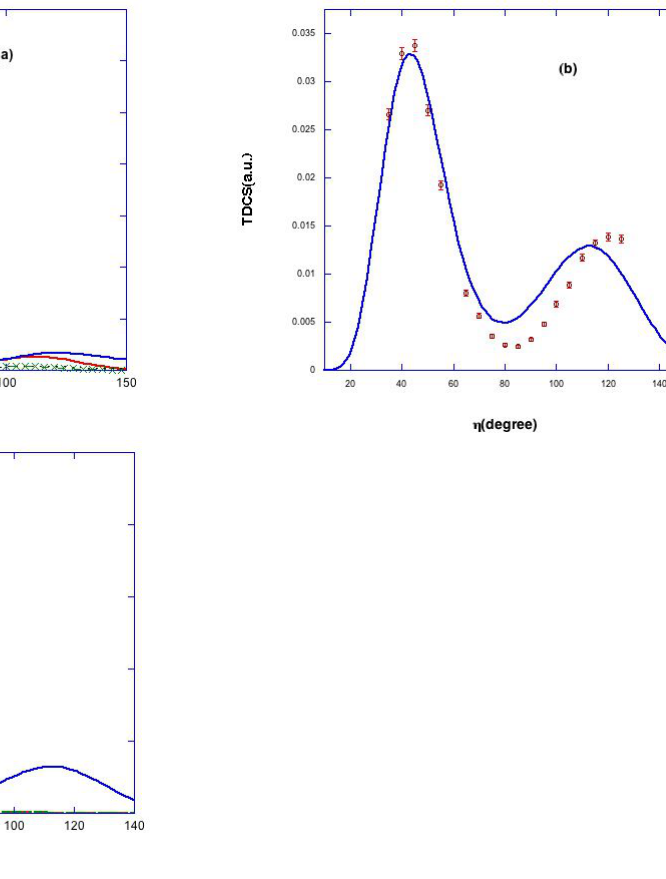
Figure 4. TDCS for the ionization of helium in coplanar symmetric geometry (i.e., Φ = 0 ◦ ) for E 0 = 54.6 eV. ( a ) Various theoretical curves for electron impact, dotted black: DWBA (singlet exchange potential); solid blue: DWBA (singlet exchange potential) with polarization but no pci, green dashed line with crosses: DWBA (singlet exchange potential) with pci but no polarization; red solid line, DWBA with polarization and pci; ( b ) Electron impact; experiment [27], theory DWBA (singlet exchange potential) with polarization and pci; ( c ) Solid blue curve DWBA (singlet exchange potential) for electron impact with polarization and pci, dashed red curve DWBA for positron impact with polarization and pci, green dashed-double dotted DWBA for positron impact with polarization but no